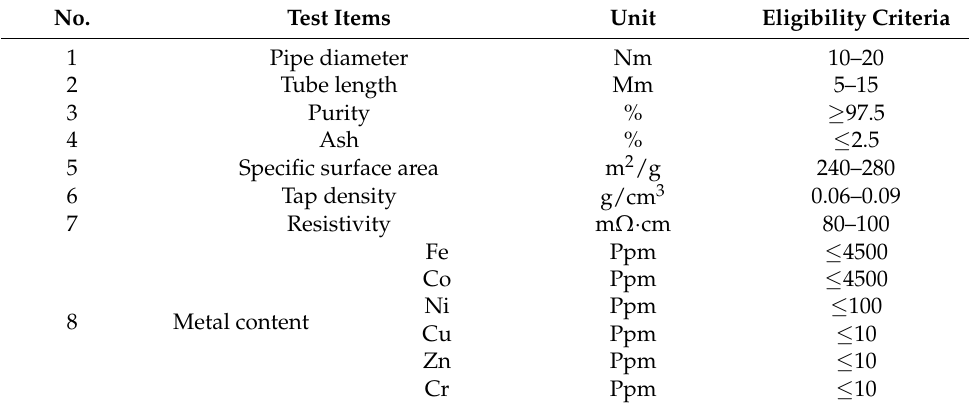
Table 2. Technical index of GM-302 multi-walled carbon